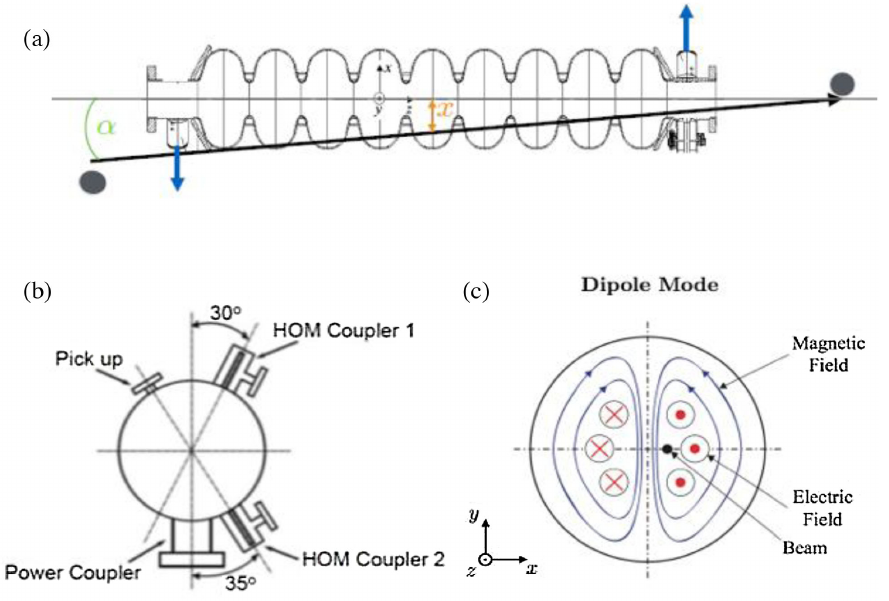
FIG. 2. (a) A schematic of a nine-cell TESLA cavity with HOM couplers shown at each end of the cavity. (b) The azimuthal orientation of the HOM couplers is shown to dampen modes. (c) The induced magnetic and electric dipole modes are shown as one example of each at the lower right for a beam offset in x. The beam is kicked in the direction of the offset initially [14].